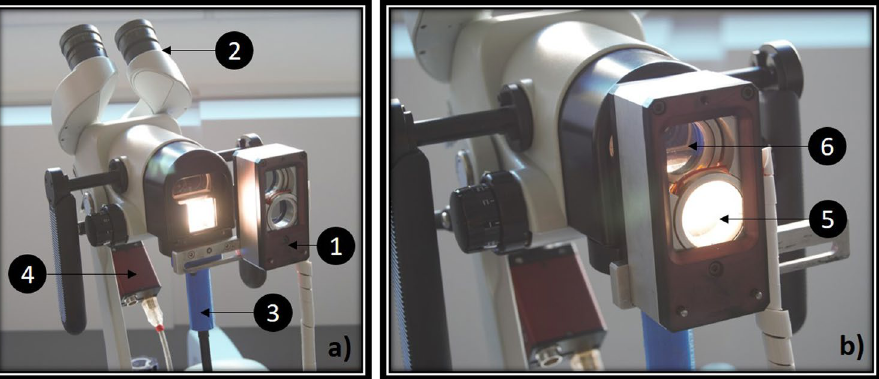
Figure 1. ( a ) Photo of the entire MPC system (1: Polarimetric head, 2: Binoculars for stereoscopic vision of the uterine cervix, 3: Liquid light guide, 4: CCD camera). The polarimetric head is in the “OFF” position, and permit classical colposcopic observations. ( b ) Polarimetric system can be slid on the “ON” position to permit the acquisition of Mueller polarimetric images (5: Polarization States Generator (PSG), 6: Polarization States Analyzer